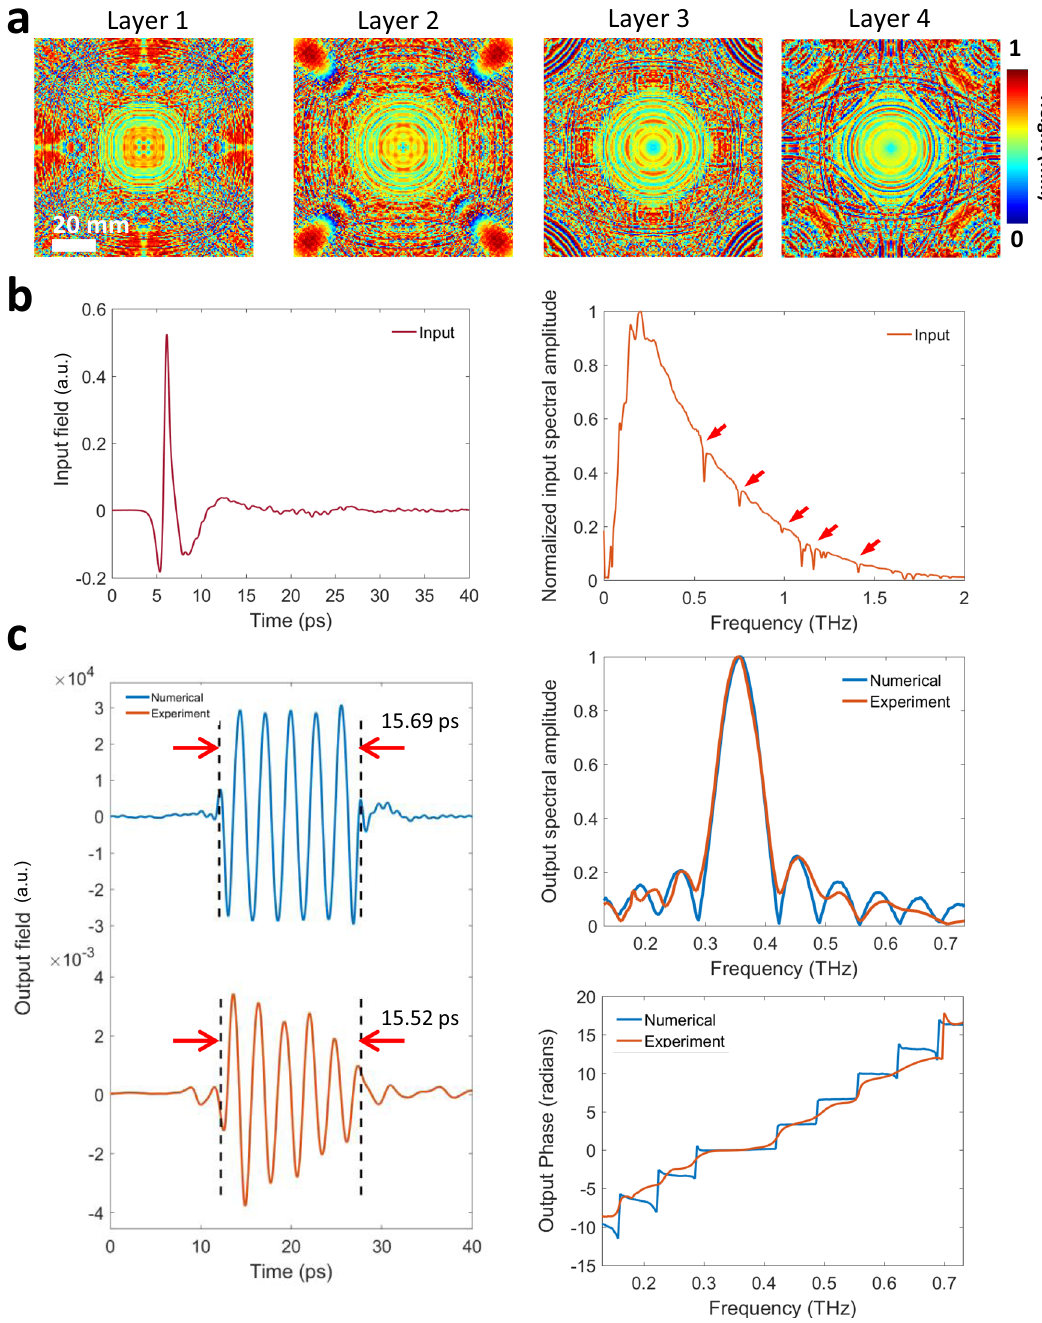
Fig. 2 Pulse shaping diffractive network design and output results. a The thickness pro fi les of the resulting diffractive layers after deep learning-based training in a computer. These diffractive layers synthesize a square pulse with a width of 15.69 ps over the output aperture for an input pulse shown in b . b Normalized input terahertz pulse measured right after the input aperture (see Fig. 1); in time-domain (left) and spectral domain (right). The red arrows on the measured spectral amplitude pro fi le represent the water absorption bands at terahertz frequencies. c Left: The numerically computed (blue) and the experimentally measured (orange) output pulses in time domain. Top right: The normalized spectral amplitudes corresponding to the numerically computed (blue) and the experimentally measured (orange) pulses. Bottom right: Unwrapped spectral phase distributions computed based on the numerical forward model (blue) and the experimentally measured (orange)